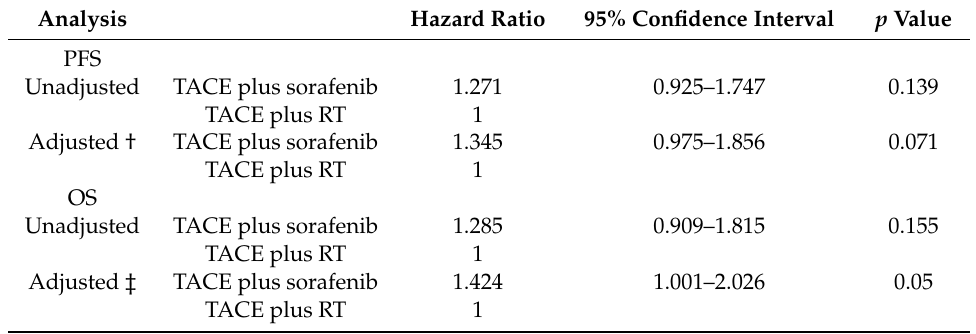
Table 3. Results of Cox proportional hazard models in subgroup without extrahepatic metastasis.